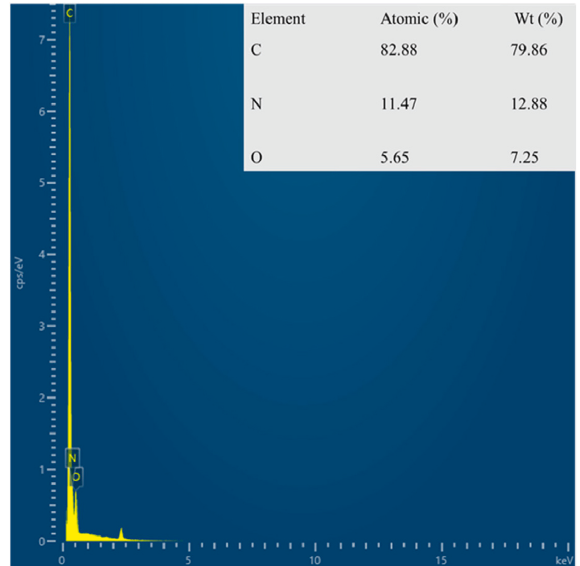
Figure 2: EDS spectra and element content analysis table of GluP